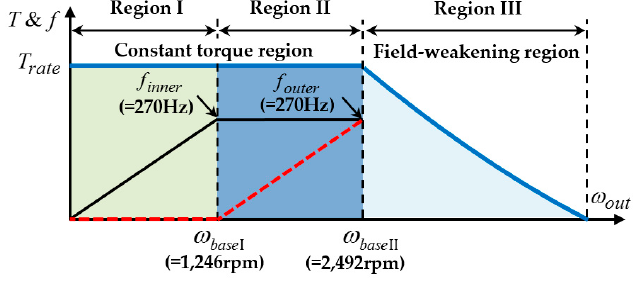
Figure 9. Speed-Torque curve with the base speed I of 1246 rpm and the base speed II of 2492 rpm, respectively. Energies 2018 , 11 , x FOR PEER REVIEW 11 of 16